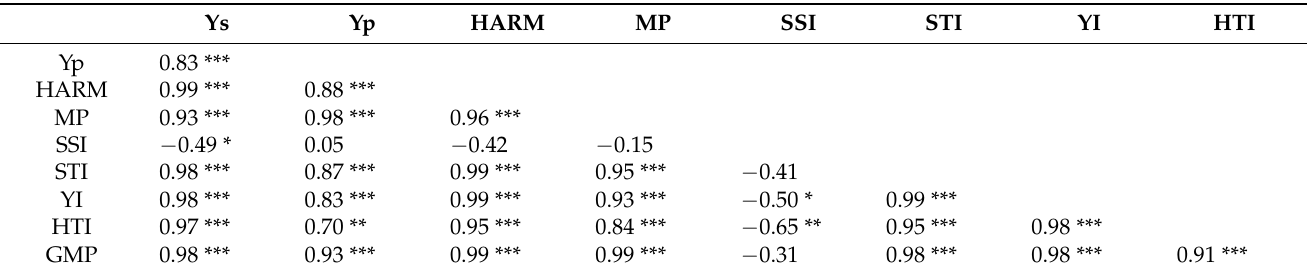
Table 10. Correlation coefficient of Ys, Yp, and heat tolerance indices.